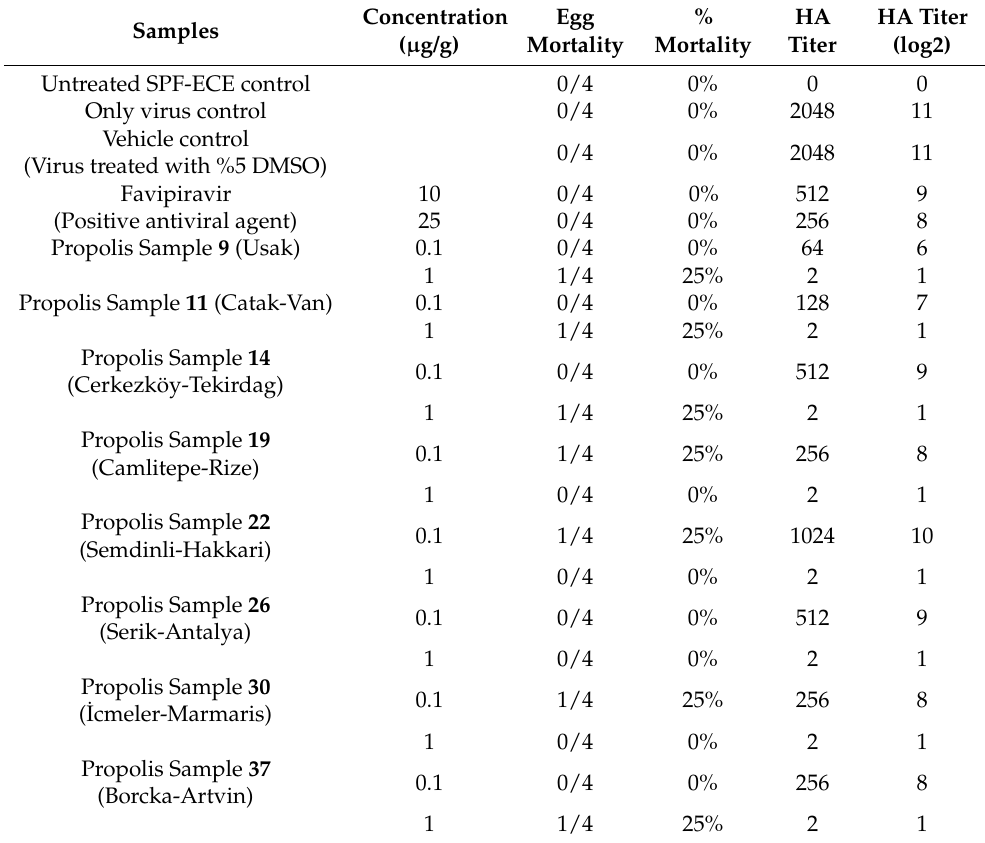
Table 3. Mortality and HA titers of chosen propolis